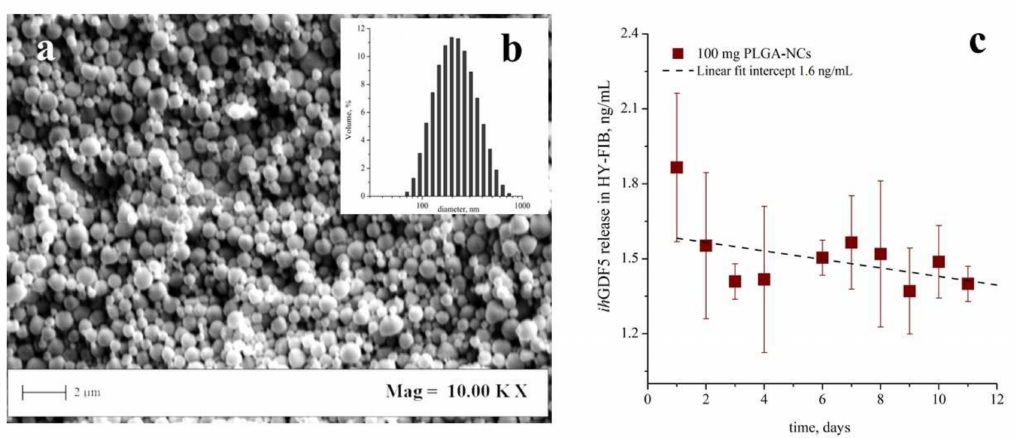
Figure 3. Poly-lactic-co-glycolic-acid (PLGA) transient carriers field emission-scanning electron microscopy (FE-SEM) image, particle size distribution, and ihGDF-5 release profile. FE-SEM images indicated spherical morphology of carriers ( a ); the size distribution set at 230 ± 80 nm their mean size ( b ). Release profiles performed in vitro at 37 ◦ C indicated a ihGDF-5 mean concentration of 1.6 ng / mL / day released from the 100 mg of PLGA-NCs loaded within HY-FIB over 11 days of culture ( c